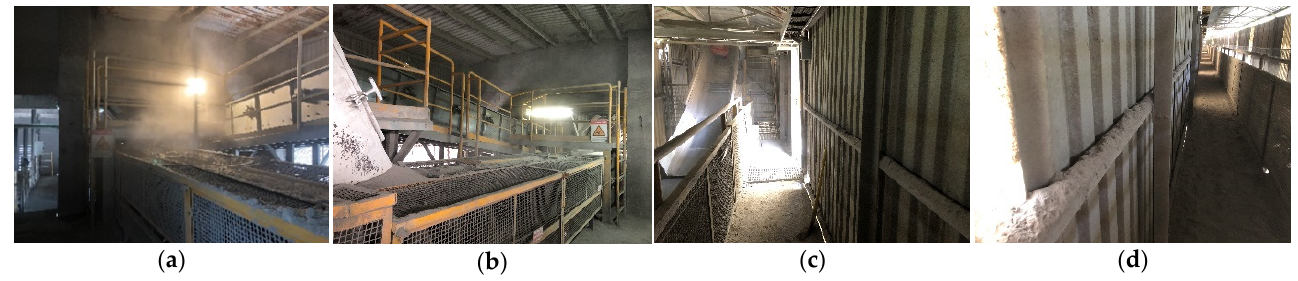
Figure 2. Some dust sources in the cement grinding plant: ( a ) mill inlet; ( b ) underneath of feed-bin; ( c ) at changed-direction point; ( d ) accumulated dust along dispatch belt conveyor.